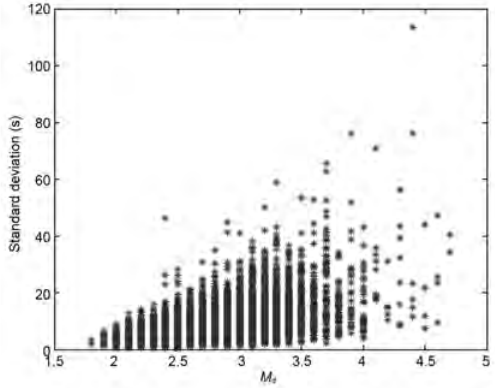
Fig. 6. Standard deviations of the absolute time ( τ s ) versus M d . The standard deviation values indicate that τ s is not